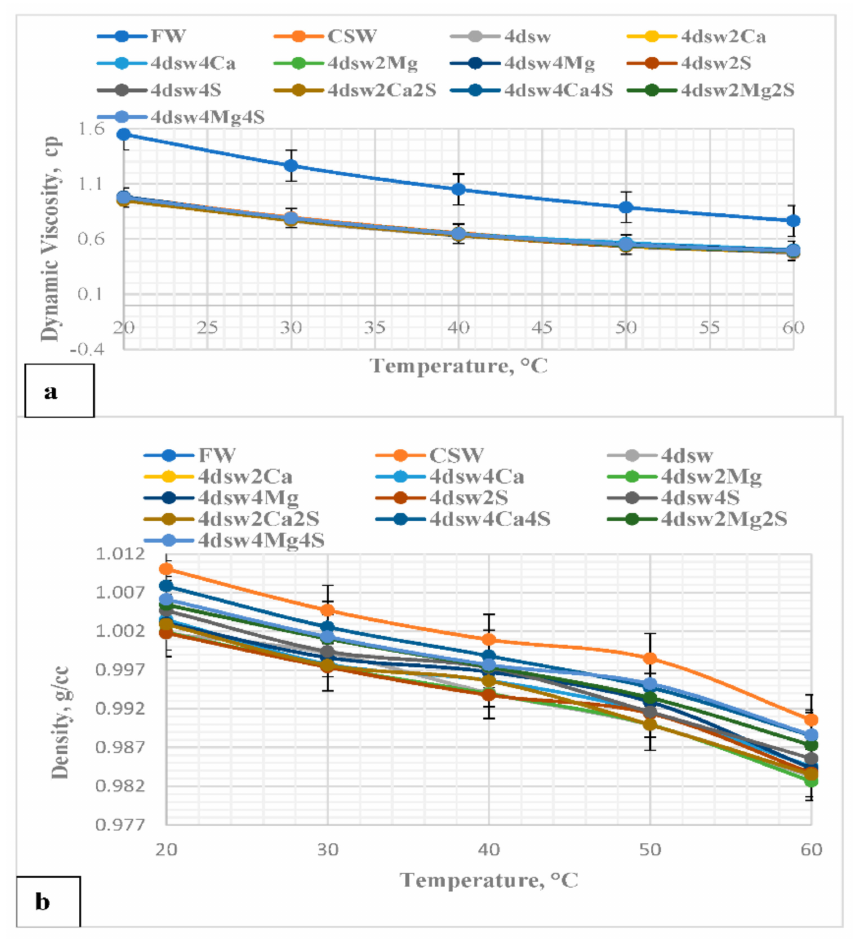
Figure 7. ( a ) Viscosity-temperature relationships for the FW and EW samples; ( b ) density-temperature relationships for the FW and EW